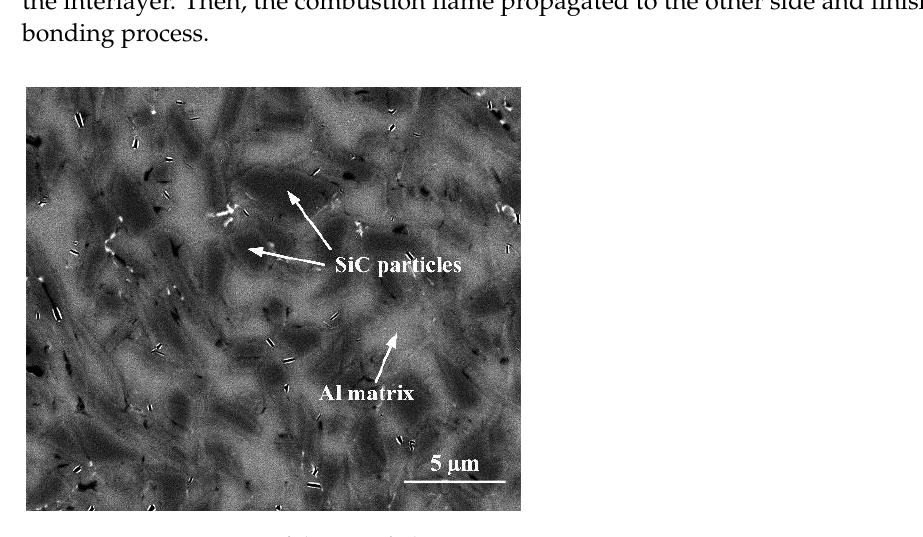
Figure 3. Schematic diagram of the shear test.